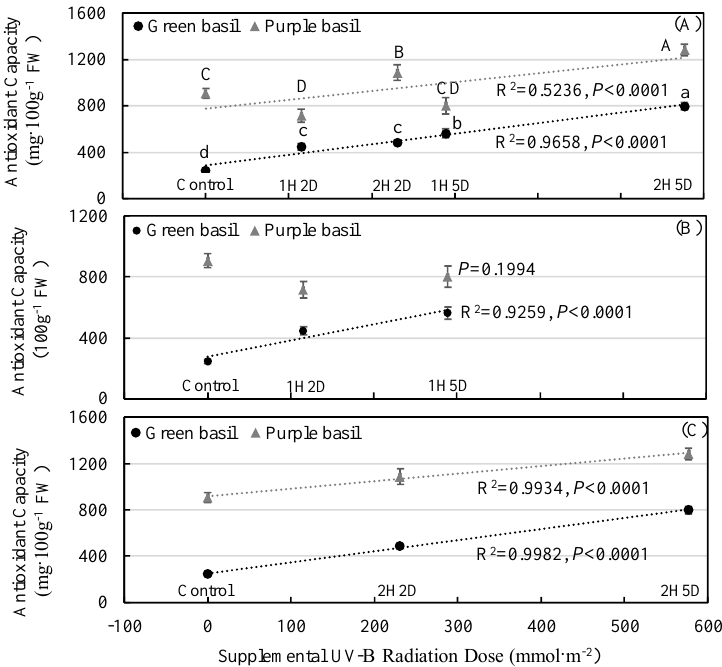
Figure 5. Correlation between antioxidant capacity of green basil ‘Improved Genovese Compact’ and purple basil ‘Red Rubin’ plants with UV-B radiation doses. Correlation test was conducted in three terms according to different UV-B radiation patterns, five supplemental UV-B radiation treatments including control, 1H2D, 2H2D, 1H5D, 2H5D ( A ) , control and 1 h·d − 1 UV-B radiation treatments ( B ), and control and 2 h·d − 1 UV-B radiation treatments ( C ). Data were pooled from two photosynthetic photon flux density (PPFD) treatments. Means followed by the same lower/upper case letters are not significantly different for green/purple basil plants, according to Student ’ s t mean comparison ( p < 0.05). Bars represent standard errors. Dashed lines show the regression between antioxidant capacity with supplemental UV-B radiation dose, according to the pairwise correlation method.